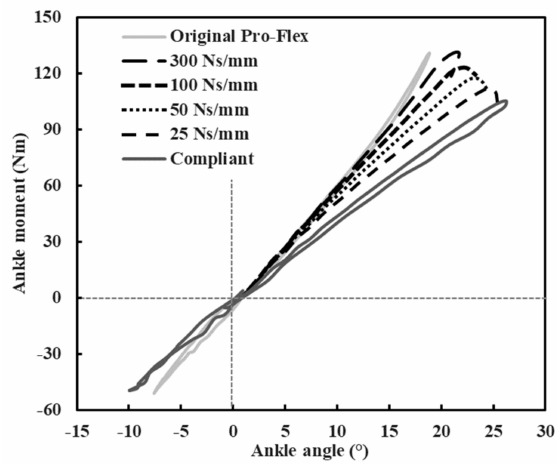
Figure 6. Design modification—Ankle moment vs. ankle angle results from the FE model. Comparison between original foot simulation (light grey) and resulting curves for the modified designs; compliant mechanical link (dark gray) where a new spring-loaded joint is introduced and actuated damping with four di ff erent damping coe ffi cients (dashed black x 4). Damping element is activated at mid-stance at 0.3 s.